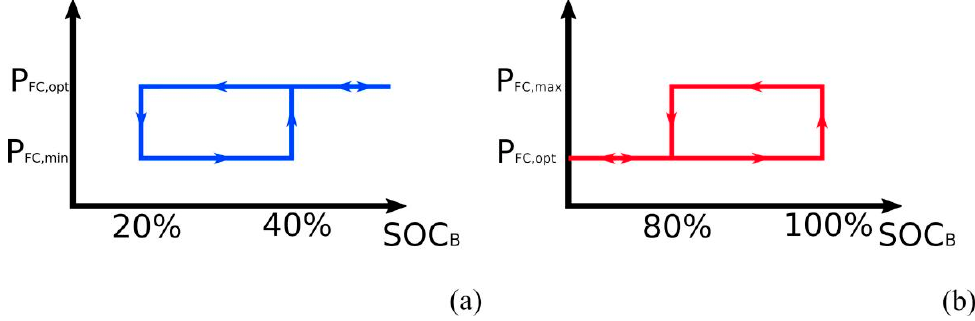
Figure 5. Hysteresis cycle of the state machine control system: ( a ) low battery SOC levels; ( b ) high battery SOC levels.